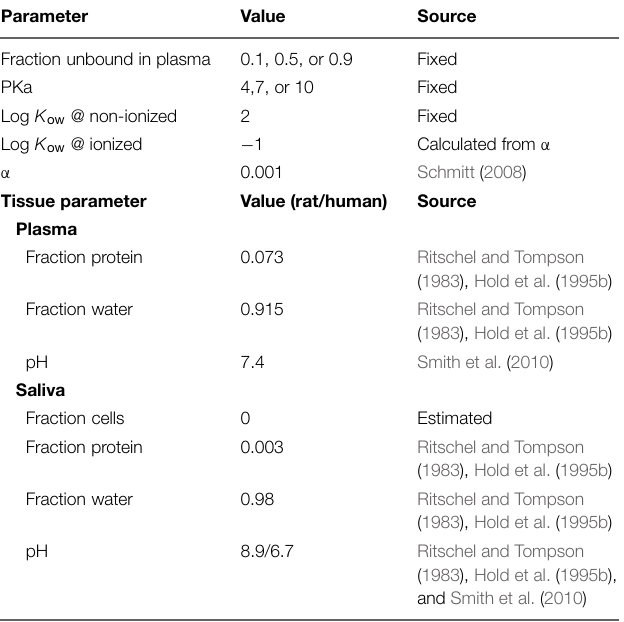
TABLE 2 | Input chemical and tissue parameters used to simulate the saliva:blood partitioning for generic over a range of pKa and protein-binding values.